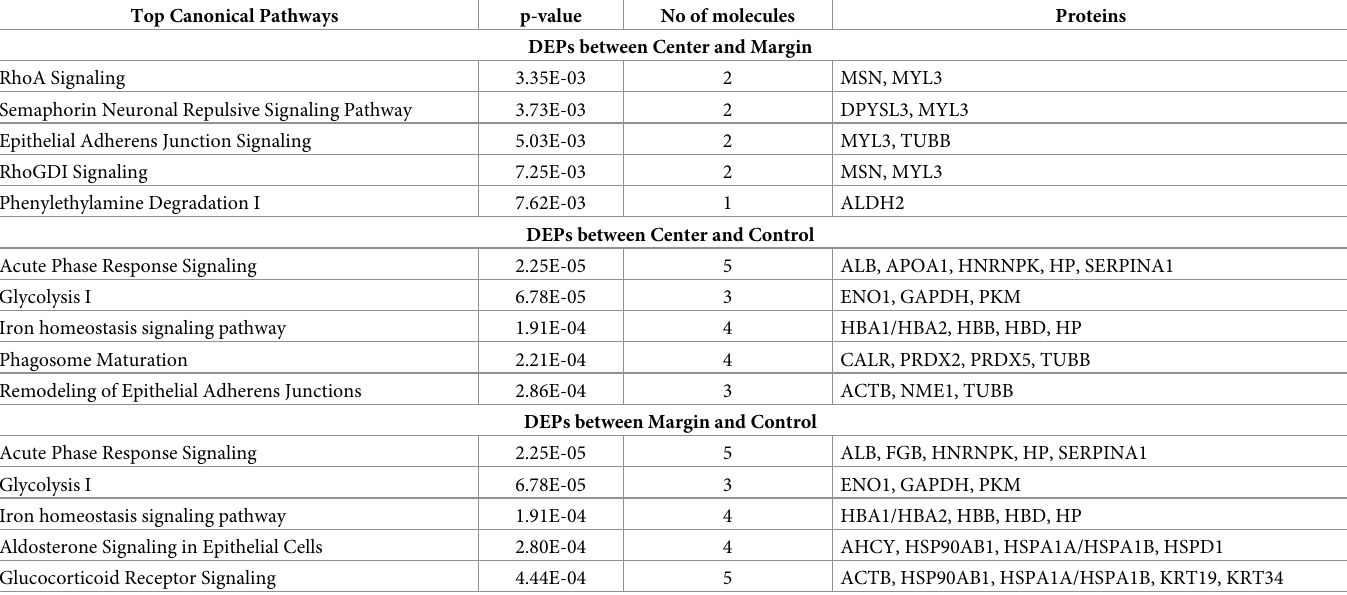
Table 1. Top canonical pathways of differentially expressed proteins (DEPs) in ADC tumor. Top Canonical Pathways